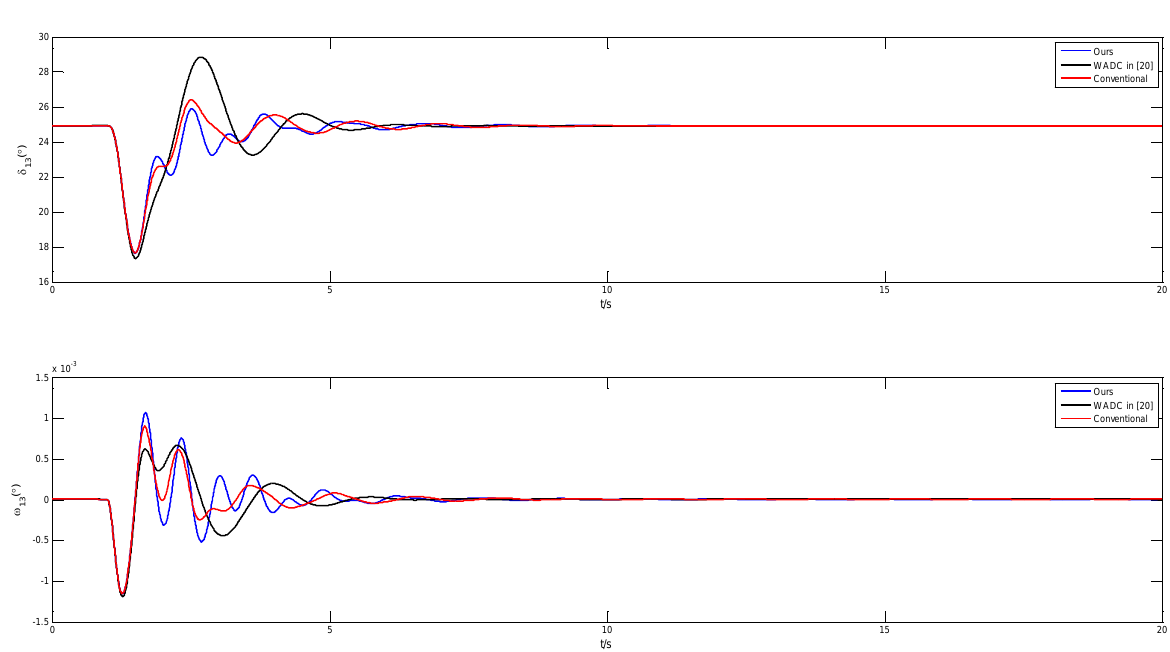
Figure 8. Response of the system in Scenario 1 when ρ = 0.3.